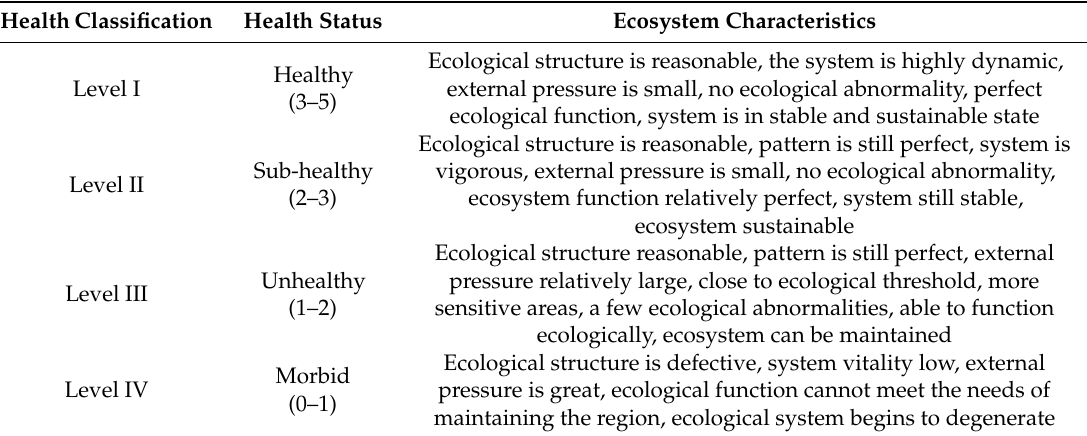
Table 4. Ecosystem health status